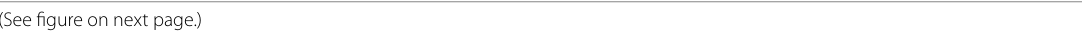
Fig. 5 Inhibitory effects of geraniin on inflammatory protein and cytokine expression in esophagus. Expression of pro-inflammatory protein TNF-α, IL-1β, COX-2, p-IkB-α and p-p65. Rats were pre-treated with geraniin 15 and 30 mg/kg, and ranitidine 30 mg/kg body weight excluding normal and RE control for 90 min before surgery. After 5 h, the esophageal mucosa was cut, and then, the was abdomen open and removed from each rat. Data are mean standard deviation (SD). Significance: ## p < 0.01 and # p < 0.05 compared with normal control group; ** p < 0.01 and * p < 0.05 compared ± with RE control